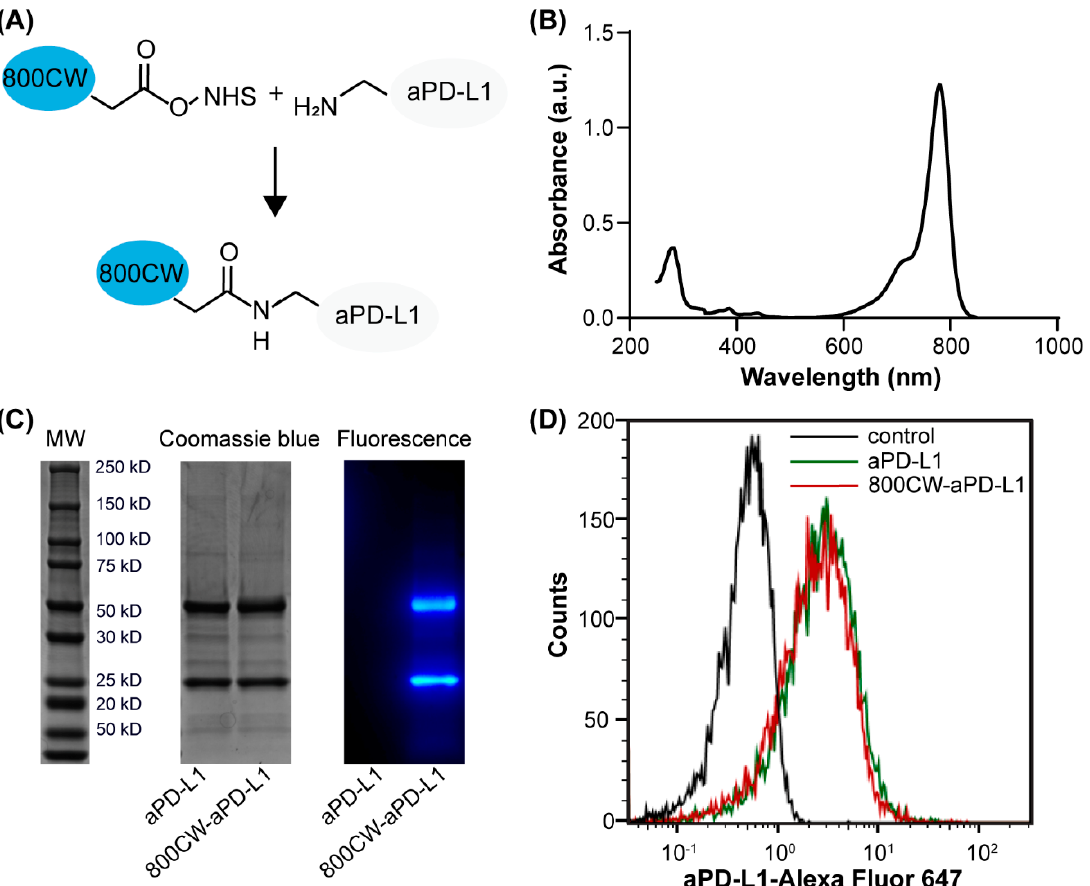
Figure 1. Analysis of 800CW-aPD-L1 conjugates. ( A ) Schematic illustration of 800CW conjugated to aPD-L1 through NHS ester reaction. ( B ) Absorbance spectrum of 800CW-aPD-L1 measured by the UV spectrophotometer. ( C ) SDS-PAGE of reduced aPD-L1 and 800CW-aPD-L1 by both Coomassie blue staining and fluorescence imaging. ( D ) Flow cytometry analysis of binding affinity of aPD-L1 and 800CW-aPD-L1 to GL261 cells with high surface PD-L1 expression (black: unstained control, red: 800CW-aPD-L1, green: aPD-L1).